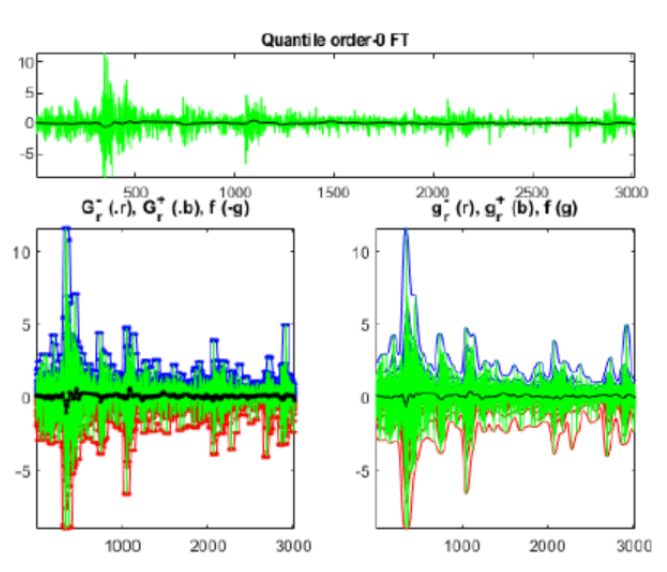
Figure 7. Minimizers of Equation (8) in quantile smoothing. Figure 7: Minimizers of equation (8) in quantile smoothing.